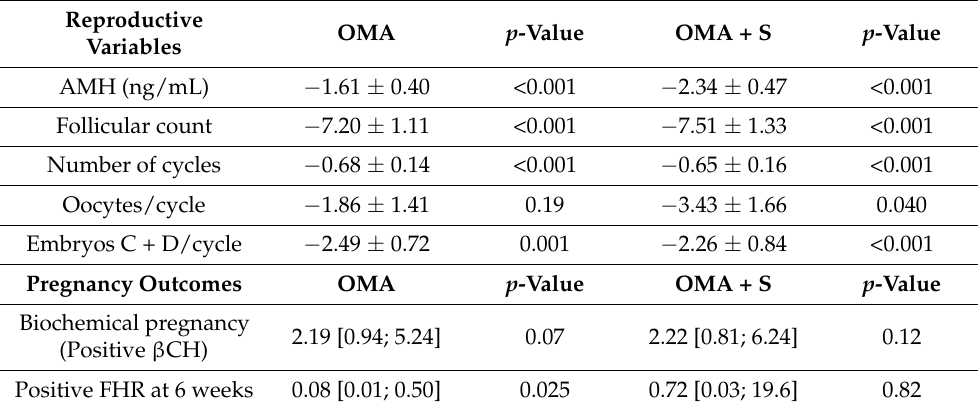
Table 4. Associations of endometriosis with reproductive and pregnancy outcomes. Reproductive